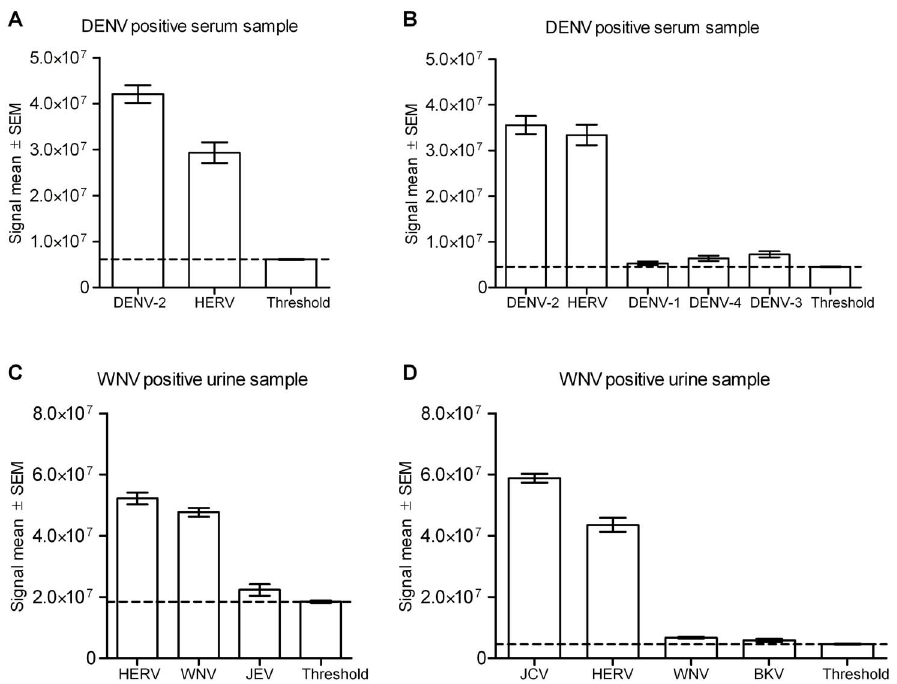
Figure 4. Microarray analysis correctly identifies emerging viruses in clinical samples. The results of microarray analysis of WT-amplified virus-positive clinical samples, using the SSI analysis method. Graphs show the signal mean for the probe intensities for each detected virus. The bar across the graph demonstrates the signal threshold at the 99 th percentile of the random control intensities. (A) Microarray analysis of a Dengue- positive serum sample. (B) Microarray analysis of another Dengue-positive serum sample. (C) Microarray analysis of a WNV-positive urine sample. (D) Microarray analysis of another WNV-positive urine sample.